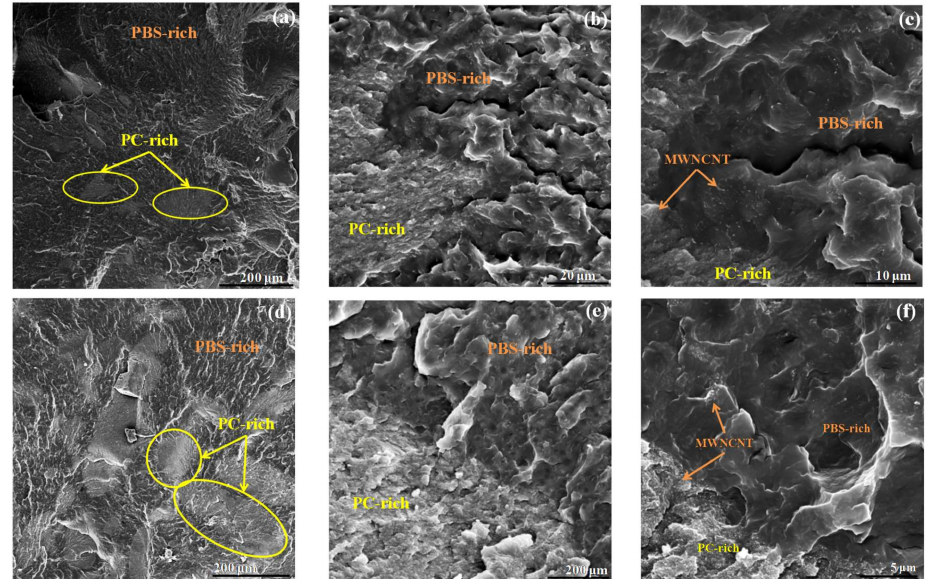
Figure 6. ( a , d ) Low and ( b , c , e , f ) high magnification SEM micrographs for the 97/(2.5/0.5) and 73/(23/4) w / w PBS/(PC/MWCNTs) nanocomposites. The yellow ellipses (see ( a , d )) indicated the PC-rich phase. Figure 6b,e correspond to the interphase, whereas in c and f the PBS- and PC-rich phases as well as the position of MWCNTs in these phases are indicated.